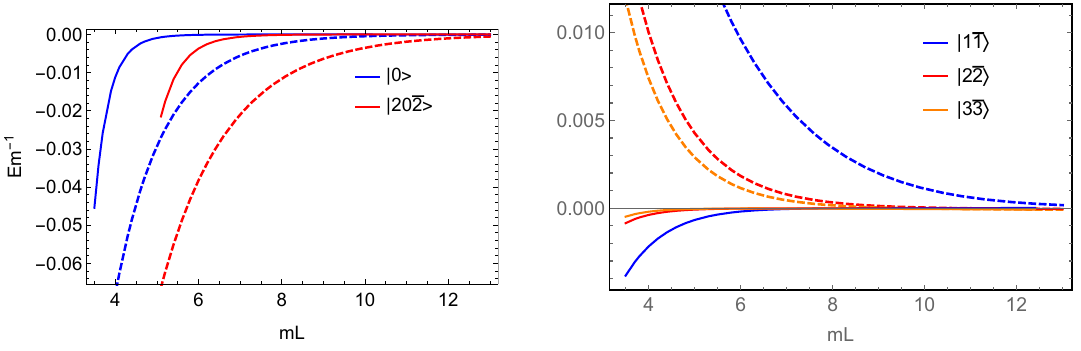
Figure 11 . Demonstration of the polynomial and exponential volume corrections for the energy. Dashed lines are the di(cid:11)erence between the Bethe-Yang energies and TCSA data and solid lines are the di(cid:11)erence of the best (cid:22) + F approximation and the TCSA data. The energy cut is 16.